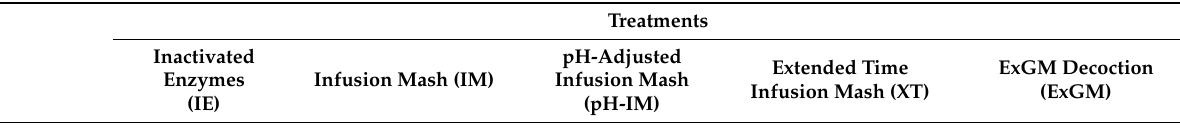
Table 1. Summary of the mashing treatments performed and the processing steps therein. Combined cells show the recipe and processing parameters that were held constant across all grains and treatments. Mashes were produced and analyzed in duplicate. A version of this table with more detailed step-by-step instructions can be found in Table